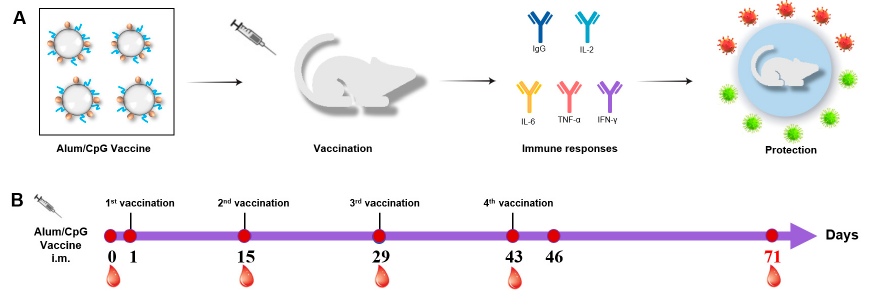
Figure 1. The immunization strategy foe SD rats. ( A ) Flow chart of preparation and ( B ) the immun ‐ ization strategy for CpG ‐ adjuvanted inactivated SARS ‐ CoV ‐ 2 vaccine in rats.